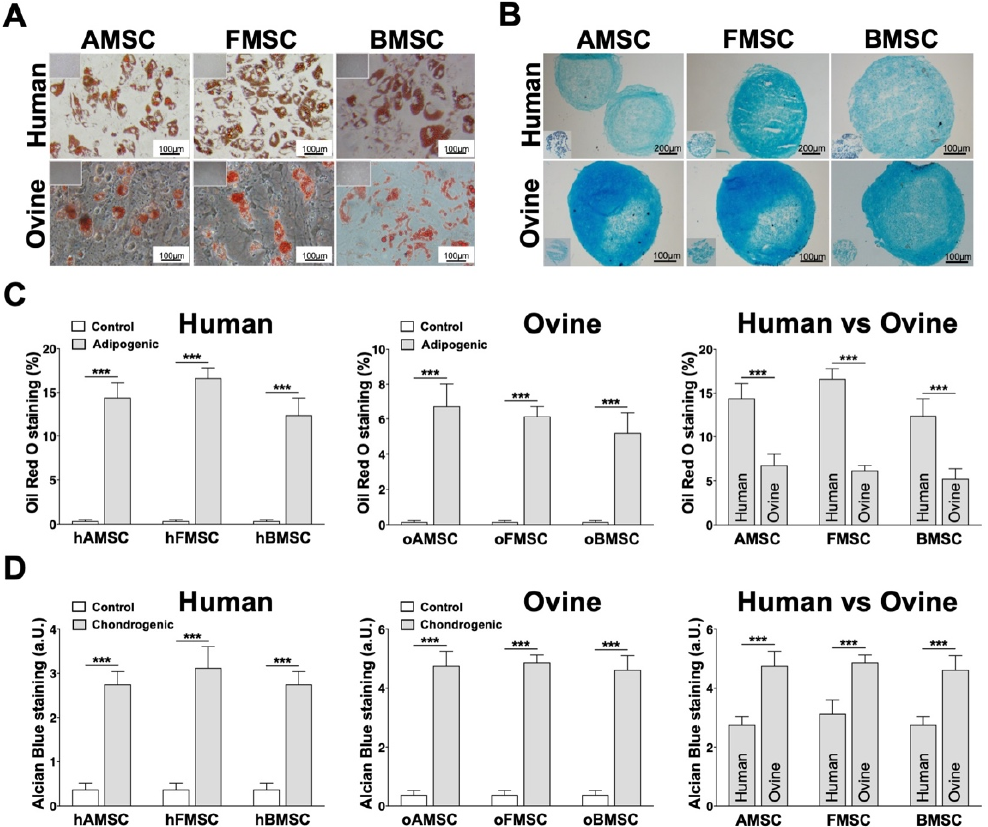
Figure 4. Adipogenic and chondrogenic differentiation of MSCs from human and ovine sources. MSCs from three human and ovine corresponding sources were induced towards the ( A ) adipogenic and ( B ) the chondrogenic lineages for 21 days. Culturing medium without any supplements was used as control. ( A ) The adipogenic differentiation was confirmed via Oil Red O and ( B ) the chondrogenic differentiation via Alcian Blue stainings. Controls are indicated in the corners. ( C ) The adipogenic differentiation rate of MSCs from human sources (left), ovine sources (middle), and human versus ovine sources (right) was evaluated by measuring the percentage of cells stained positive using cellSens Dimension software. ( D ) The chondrogenic differentiation rate of MSCs from human sources (left), ovine sources (middle), and human versus ovine sources (right) was depicted by setting a semi-quantitative score based on the intensity of Alcian Blue staining: (1) very weakly positive, (2) weakly positive, (3) moderately positive, (4) markedly positive, and (5) strongly positive. Data are either representative pictures or expressed as average ± SEM of 3–4 donors per source. *** p < 0.001, Student’s two-tailed unpaired t -test.